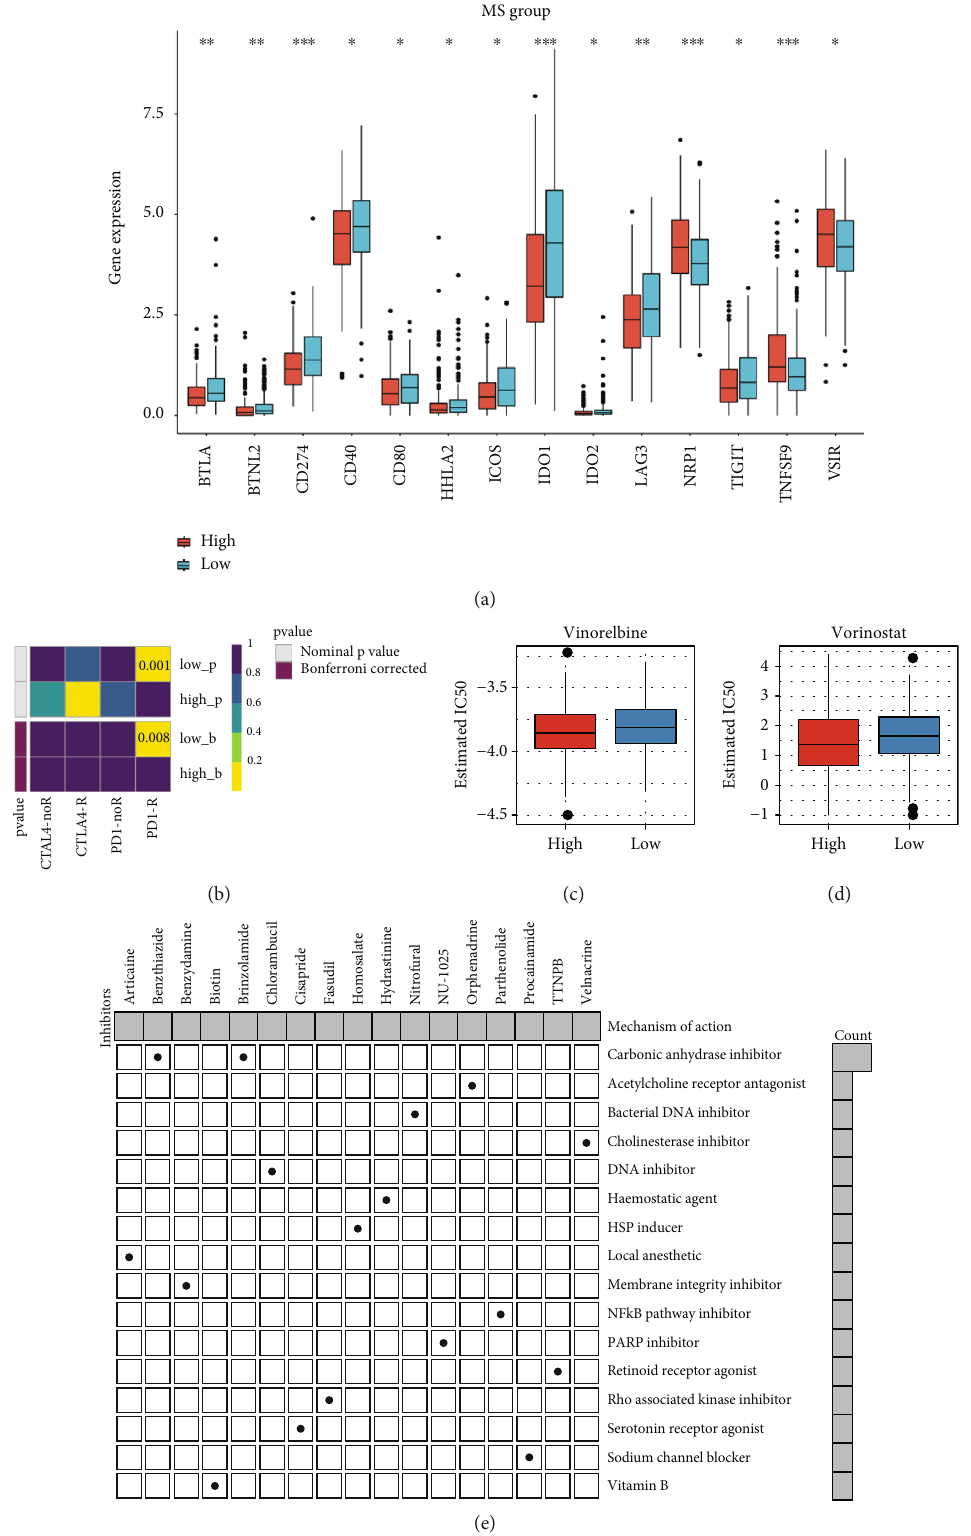
Figure 8: Immune checkpoint and chemotherapeutic reaction analyses. (a) Di ff erential expression analysis of immune checkpoint in MS groups. (b) Heatmap of expression of PD1 and CTLA4. (c) IC groups. (e) CMap analysis to identify the potential compounds targeting between MS groups and their corresponding